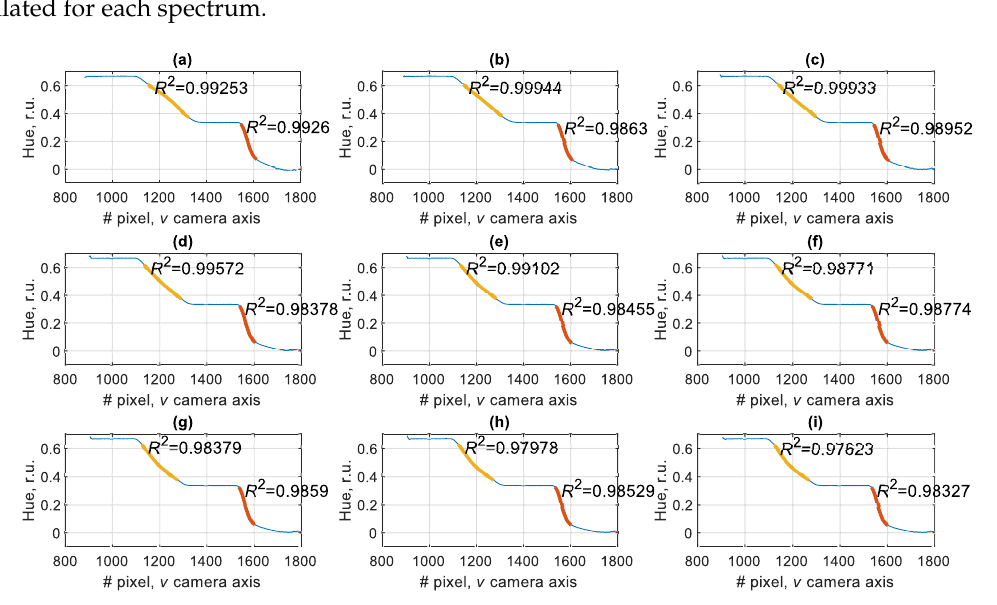
Figure A1. Comparison of spectrum image hue values distributions along the v axis for different color temperature values: ( a ) T = 3000 K, ( b ) T = 3500 K, ( c ) T = 4000 K, ( d ) T = 4500 K, ( e ) T = 5000 K, ( f ) T = 5500 K, ( g ) T = 6000 K, ( h ) T = 6500 K, ( i ) T = 7000